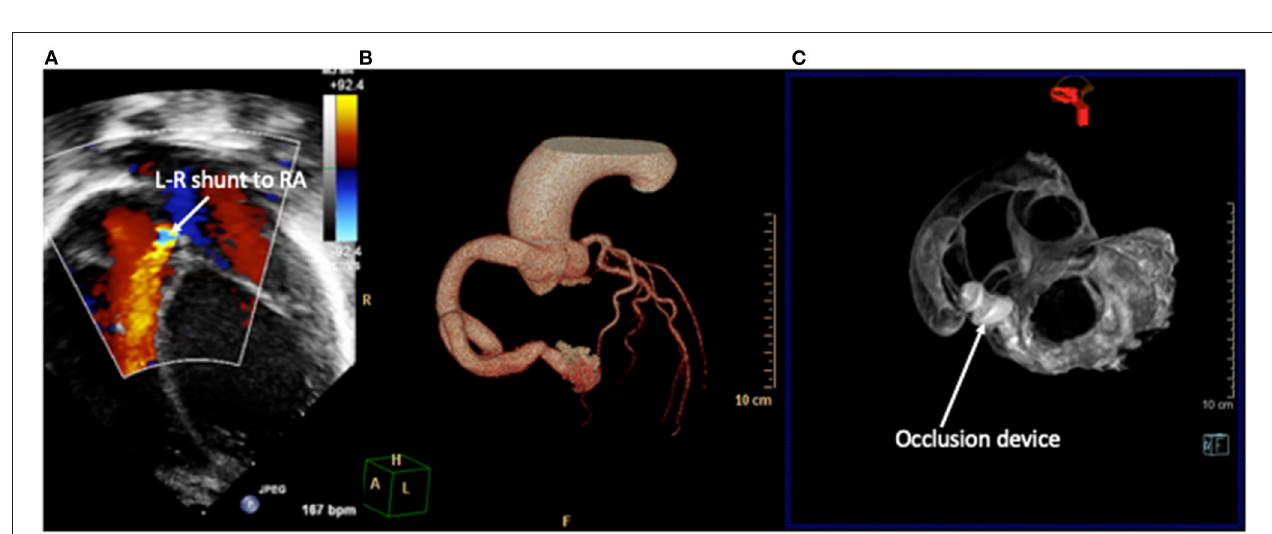
FIGURE 5 | A tortuous duct as seen on 2D color Doppler echocardiography (A) , with clear delineation of the shape, dimensions, and insertion points on contrast-enhanced CT (B) . This is in comparison to a straight duct seen on CT in image (C) . CT Images courtesy of Dr. Sujeev Mathur, Evelina London Children’s Hospital.